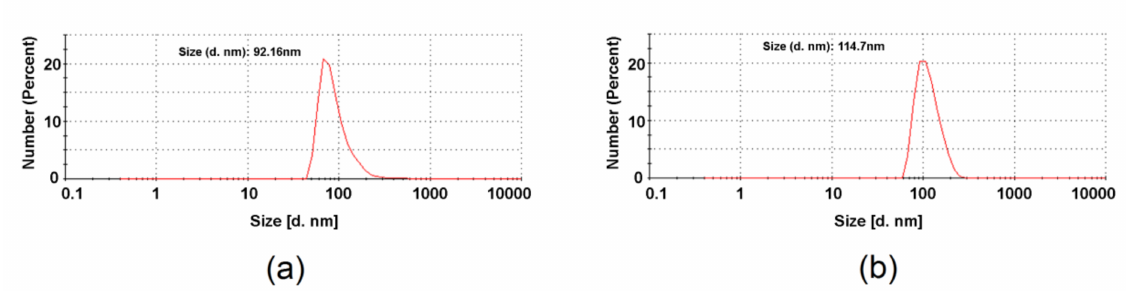
Figure 4. Size distributions obtained from DLS measurements for: fullerenol 60F ( a ) and C 60 fullerene gentamicin conjugate 60FGG ( b